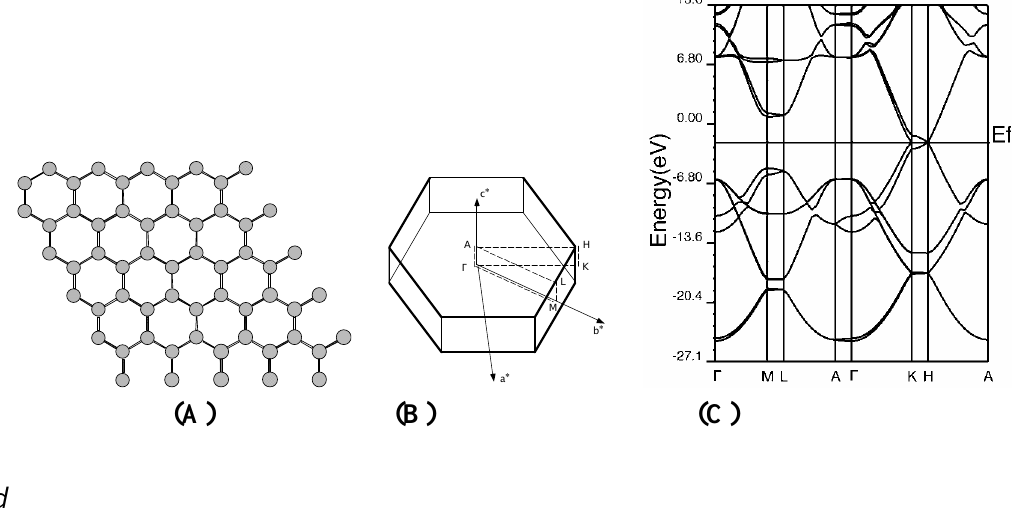
Figure S1. (A) The calculated model of graphite. (B) The calculated B.Z. (C) The obtained band structure. The detail information is given in the text.